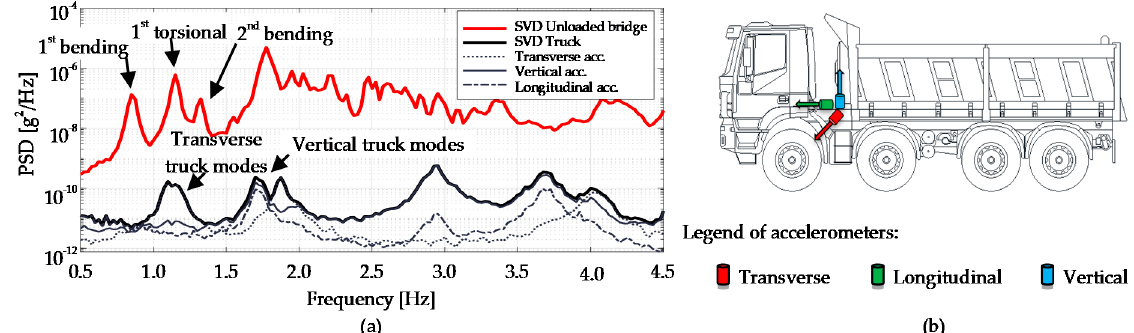
Figure 21. Dynamics of the tested truck: ( a ) frequency content, and ( b ) AVT layout.